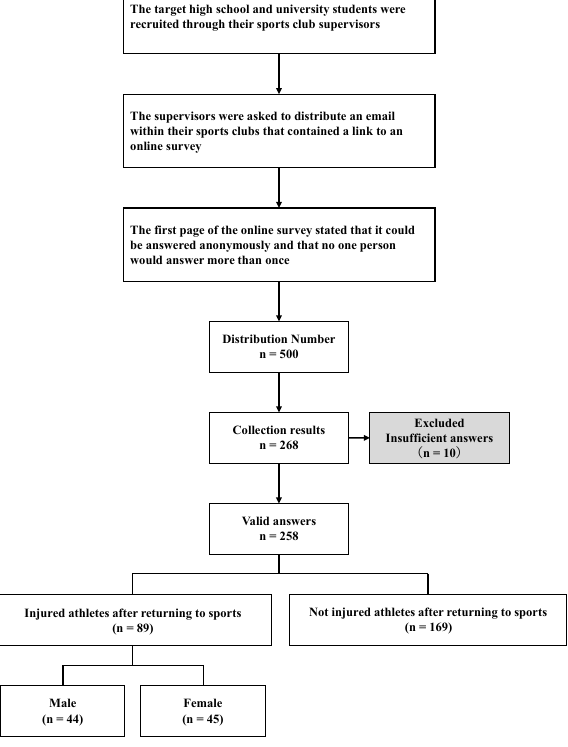
Fig. 1. Flowchart of the target recruitment method and anal- ysis